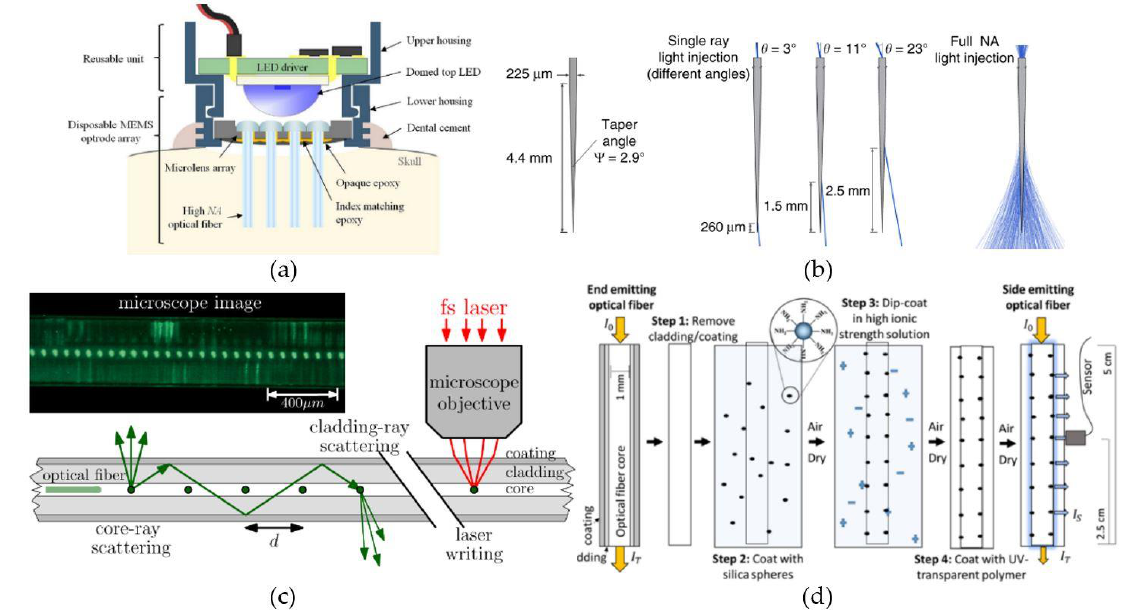
Figure 4. Multi-site and broad-range illumination with optical fibers. ( a ) A MEMS optrode array consisting out of a 4 × 4 array of optical fibers coupled to a single LED-source. Reproduced with permission from [130]; published by Elsevier, 2018. ( b ) Tapered optical fibers can both achieve light illumination at discrete positions along its length and across broad brain volumes, by injecting light at specific input angles and over the entire input range, respectively. Reproduced with permission from [132]; published by Springer Nature, 2017. ( c ) Modification of a step-index optical fiber by introducing femtosecond laser induced scattering centers, to obtain side emission at discrete positions along the length of the fiber. Reprinted with permission from [133] © The Optical Society. ( d ) Side-emitting optical fiber obtained by attaching nanoparticles, which function as scattering centers, on the surface of an uncladded glass fiber. Reprinted with permission from [134]. Copyright 2019 American Chemical Society.